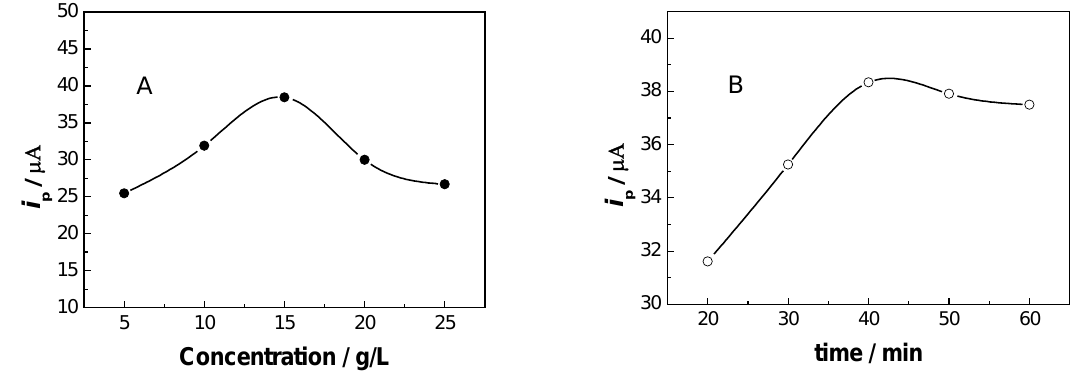
Figure 2. Effect of the OCMCS concentration (A) and the modification time (B) on the anodic peak current of DPV for 5.0 × 10 -6 M DA at the modified electrode. The experimental parameters are similar to Figure